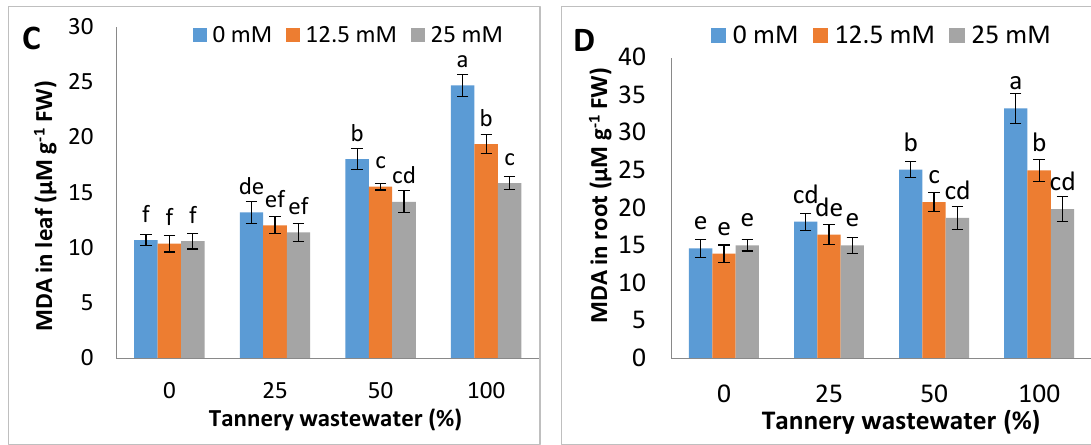
Figure 4. Graphs showing effect of foliar spray of zinc chelated lysine (0, 12.5, 25 mM) on hydrogen peroxide and MDA in leaves ( A , C ) and roots ( B , D ) of maize plants, growing under 0%, 25%, 50%, 100% concentration of tannery wastewater. Values are means of three replicates. Statistical analyses were carried out by ANOVA, followed by Tukey’s Post-Hoc test.